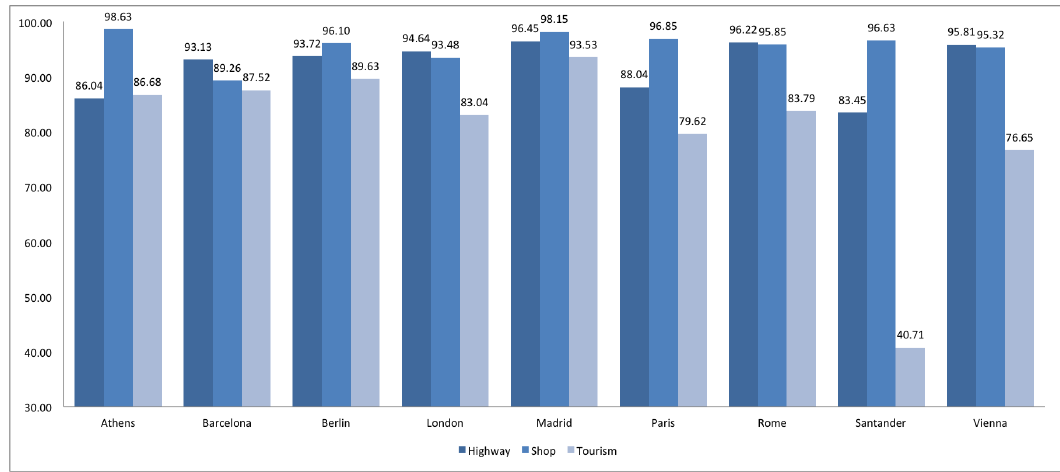
Figure 22. Compliance study in Europe. Percentage of commonly used keys.